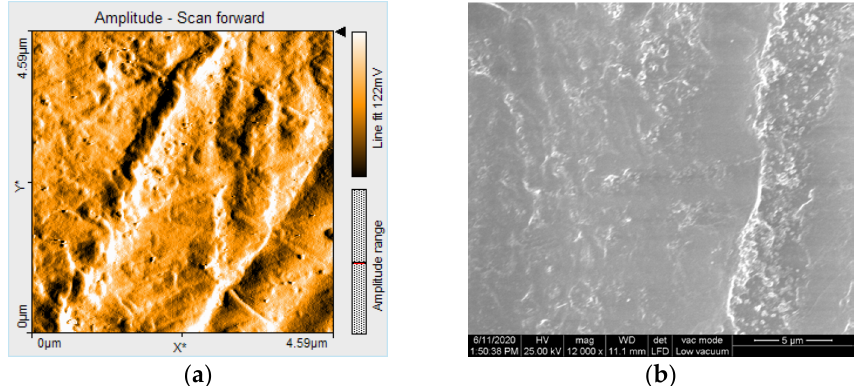
Figure 19. ( a ) Scanning amplitude (AFM) and ( b ) corresponding SEM image for a sample (BWX) with high nanoroughness values: Sa = 15 nm, Sp = 63 nm, Sv = − 54 nm.